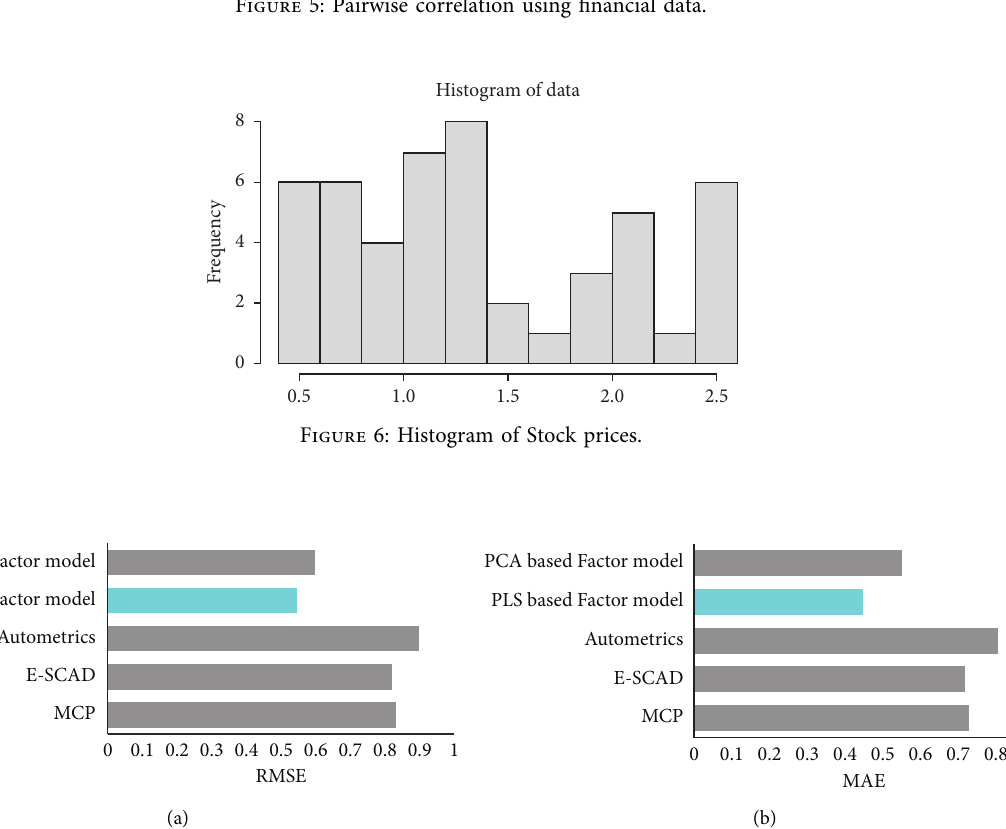
Figure 5: Pairwise correlation using financial data.